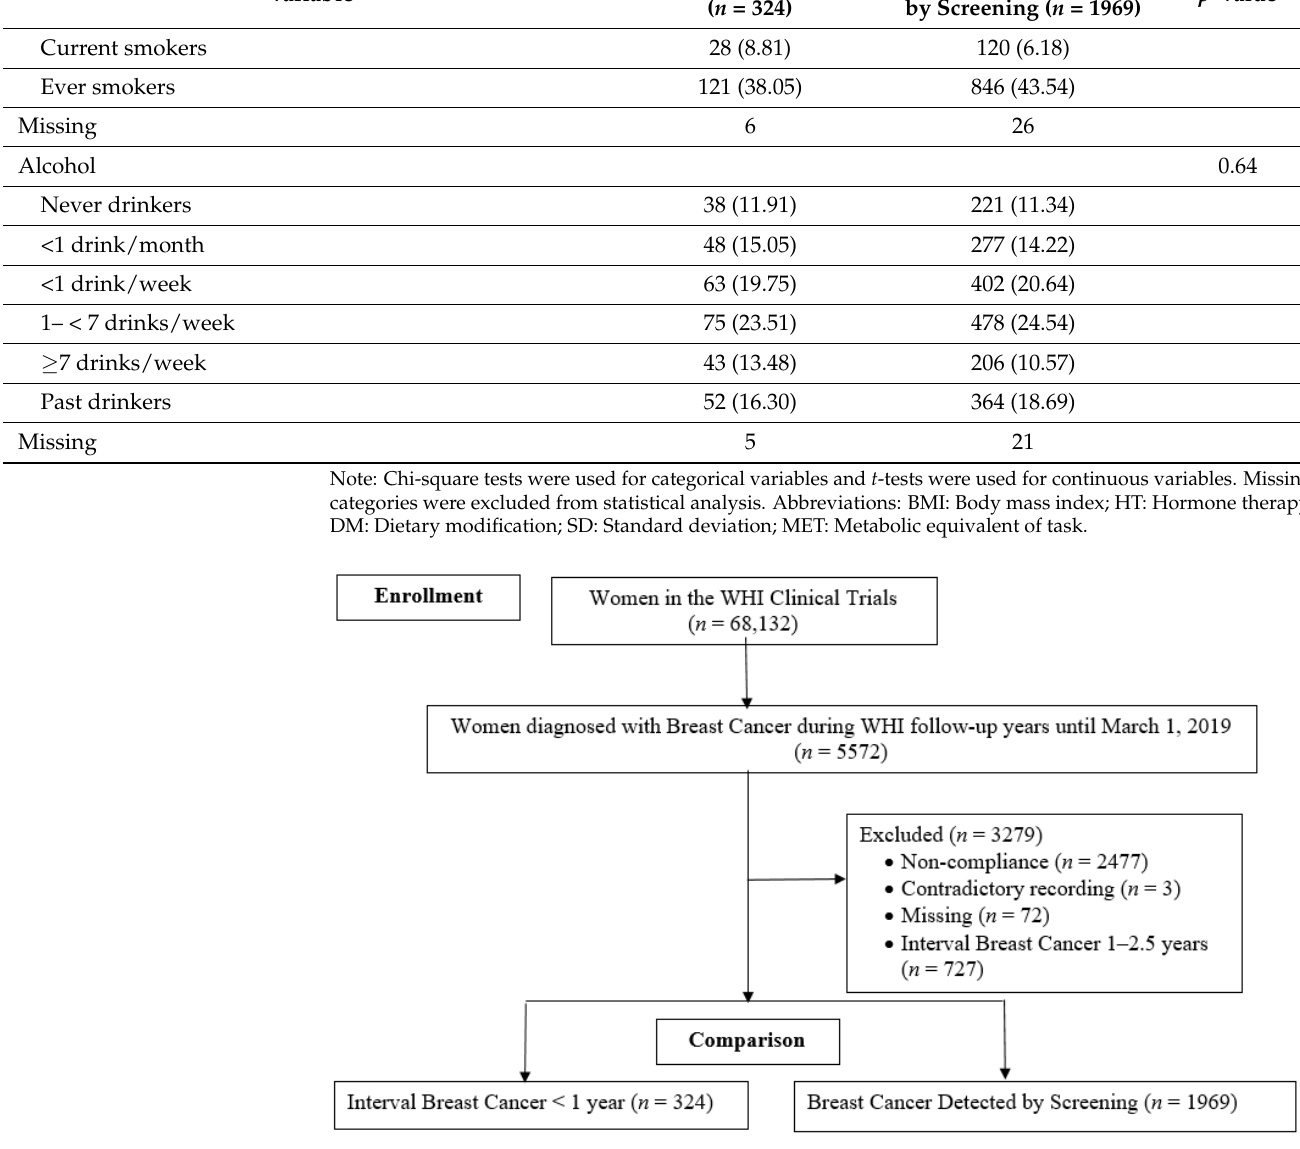
Figure 1. Flow chart of Women’s Health Initiative (WHI) participants included in the analyses.